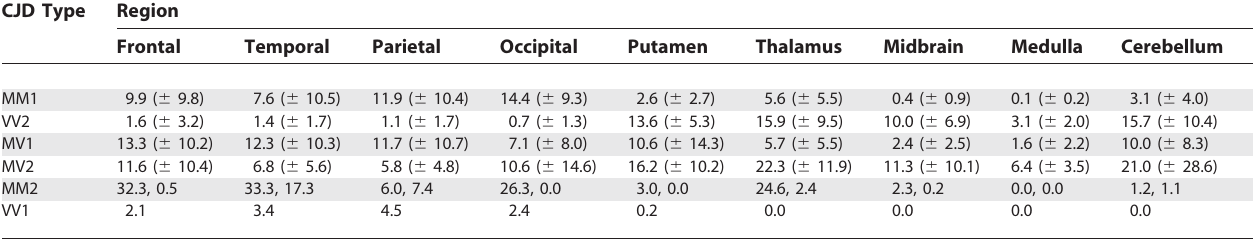
Table 2. PrP Sc Quantities in Defined Brain Areas CJD Type Region Frontal Temporal